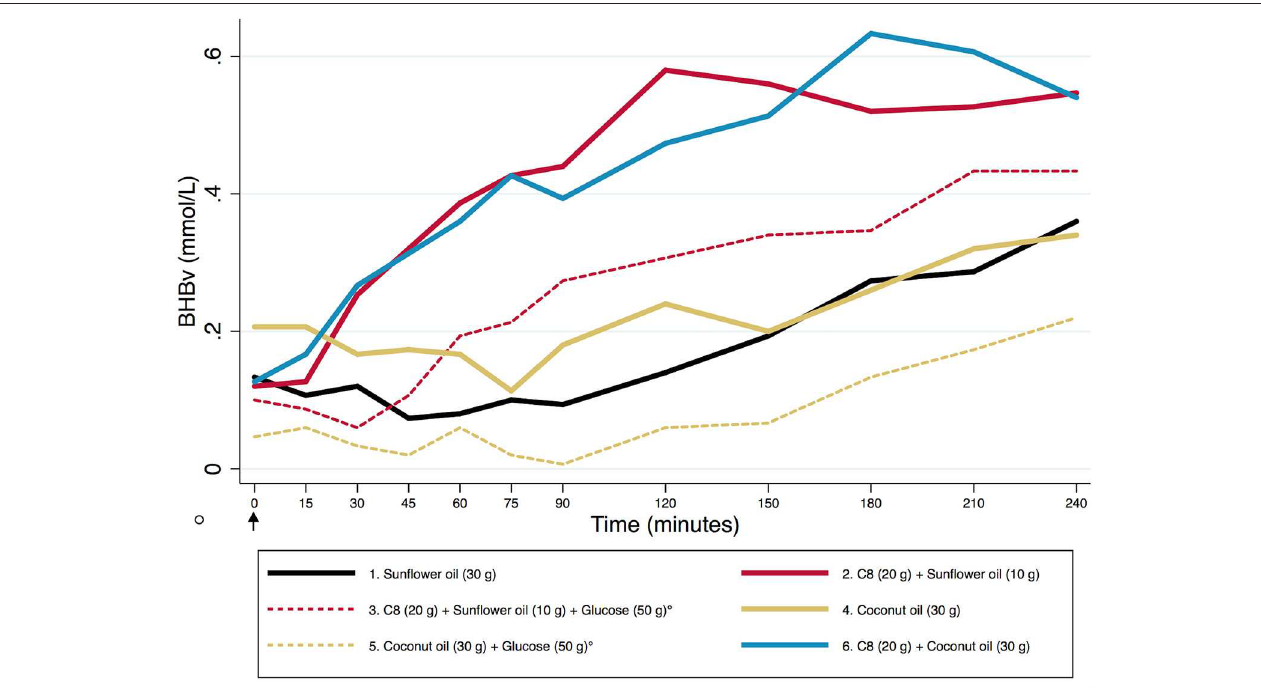
FIGURE 2 | The dynamics of BHBv during T0–T240 (minutes). A descriptive graph based on absolute mean values. The arrow at T0 indicates the start of ingestion of coffee with fatty acids. The circle indicates intake of glucose (arms 3 & 5 only, striped lines), 15min before the blood test performed immediately before T0. BHBv, β -hydroxybutyrate in venous whole